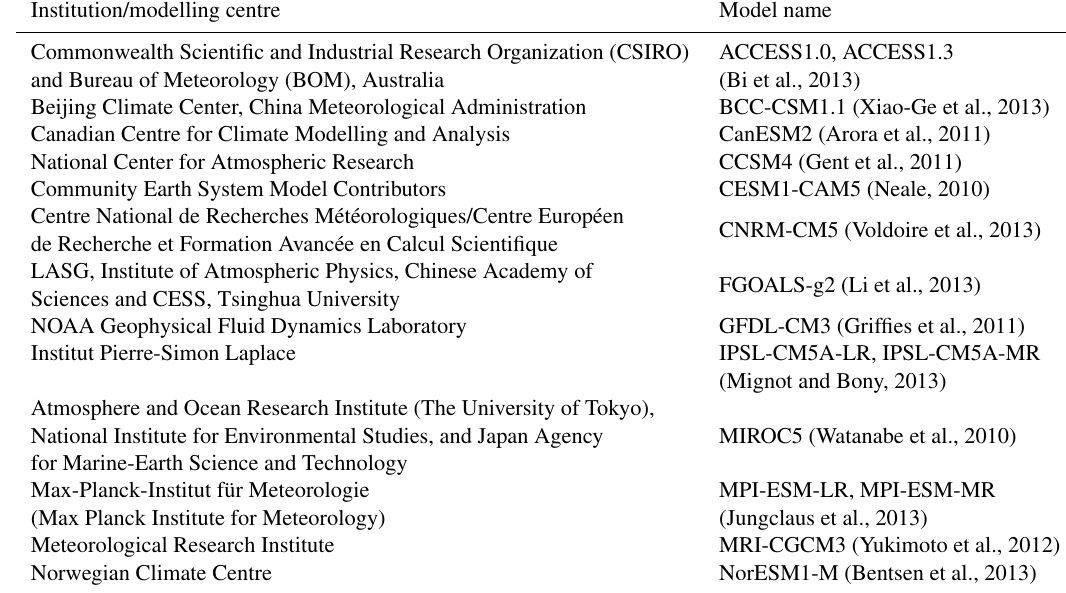
Table 1. Summary of models from CMIP5 used in the study, showing the institution/modelling centre and official model